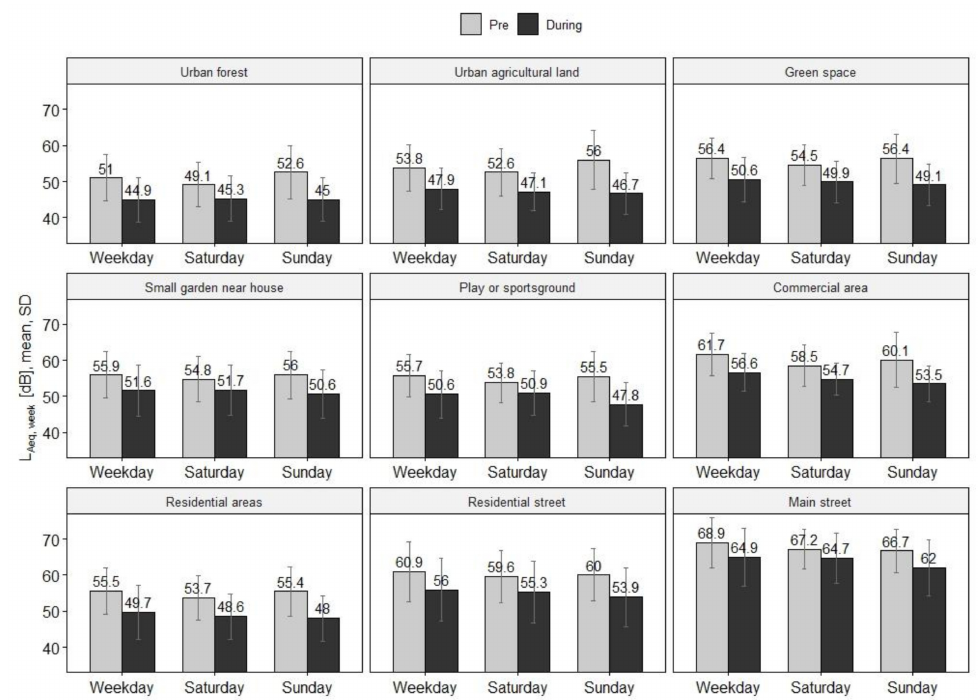
Figure 4. Comparison of noise levels on weekdays and weekends by land use category. Mean L Aeq,week for all 22 devices and their corresponding standard deviation (SD) are